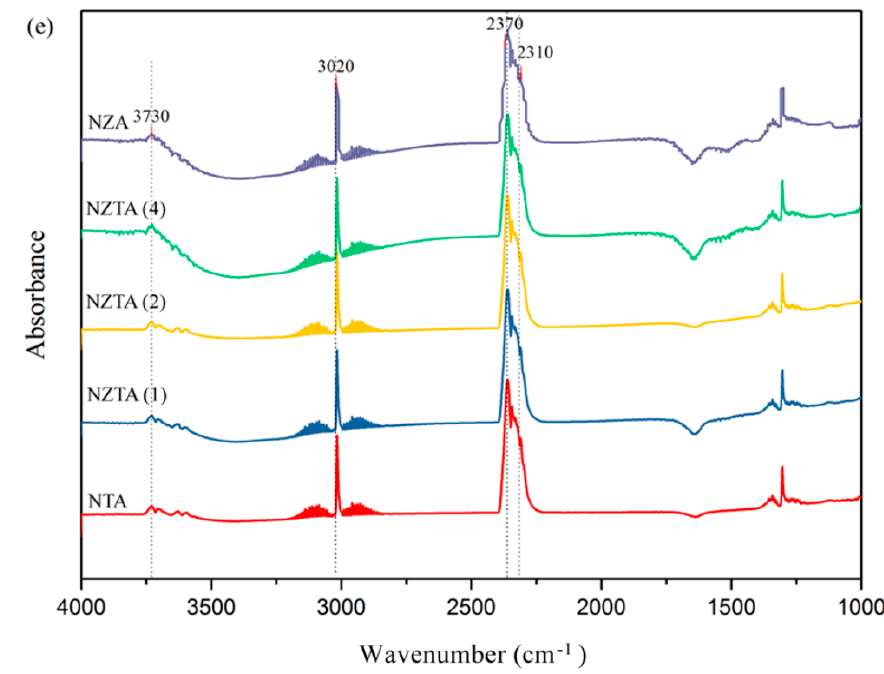
Figure 5. In situ DRIFT spectra of CH 4 -CO 2 adsorbed over the prepared catalysts at different reaction temperature over reduced catalysts ( a ) 600 °C, ( b ) 550 °C, ( c ) 500 °C, ( d ) 450 °C, ( e ) 400 °C.